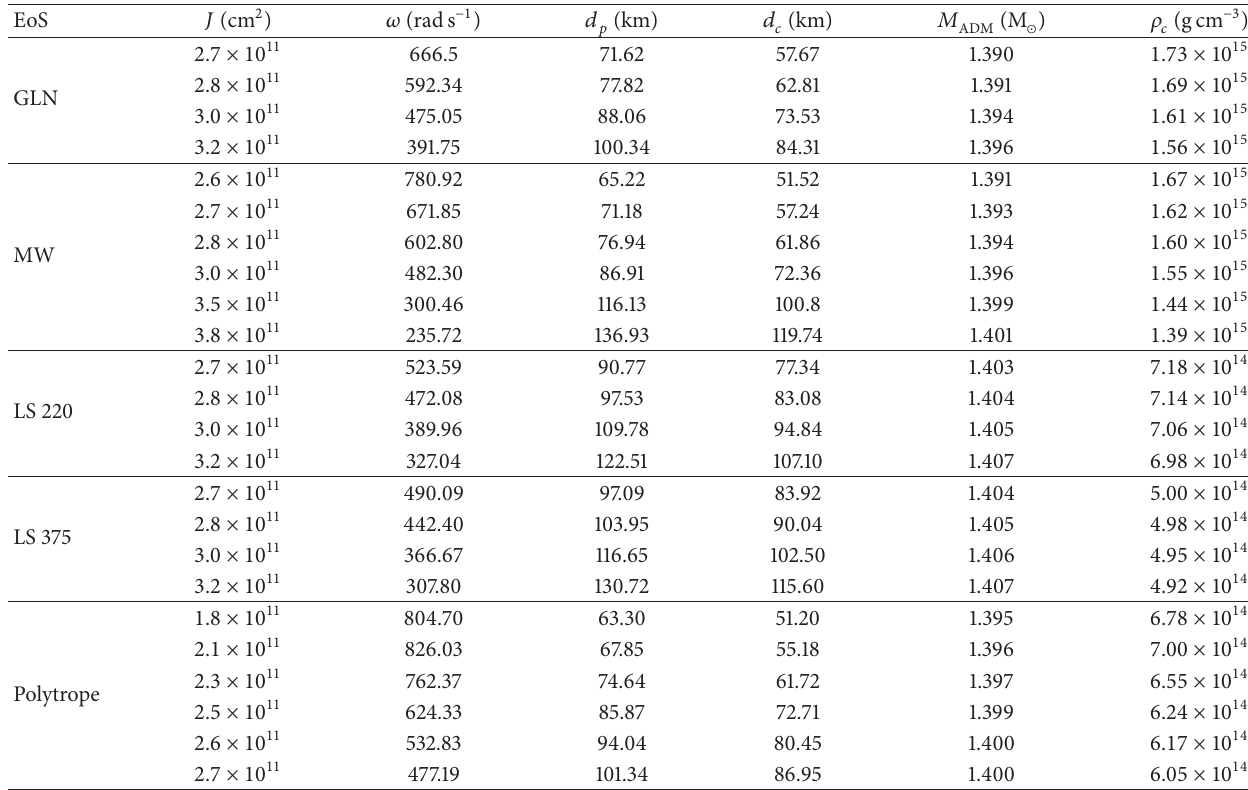
Table 2: Orbital parameters for each